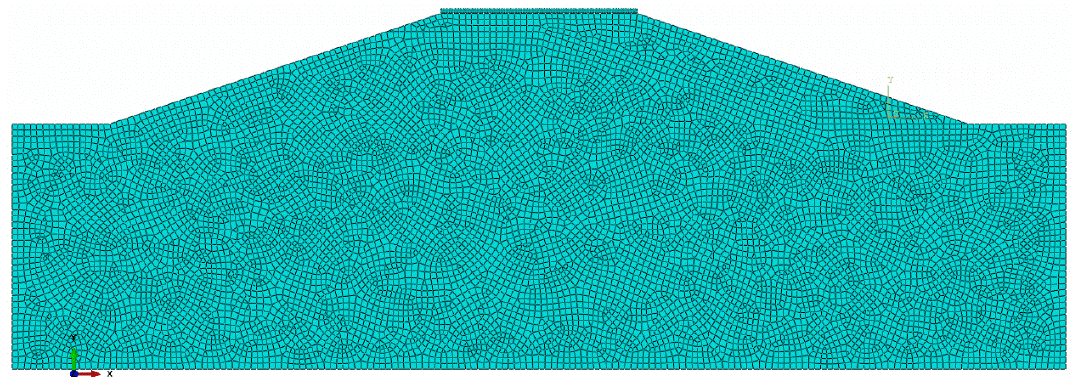
Figure 6. Mesh size = 0.25 m.